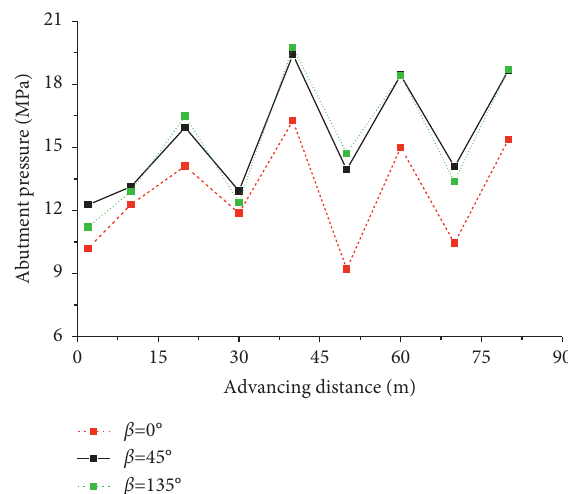
Figure 17: Abutment pressure distribution in the limit equilibrium area with different joint azimuth